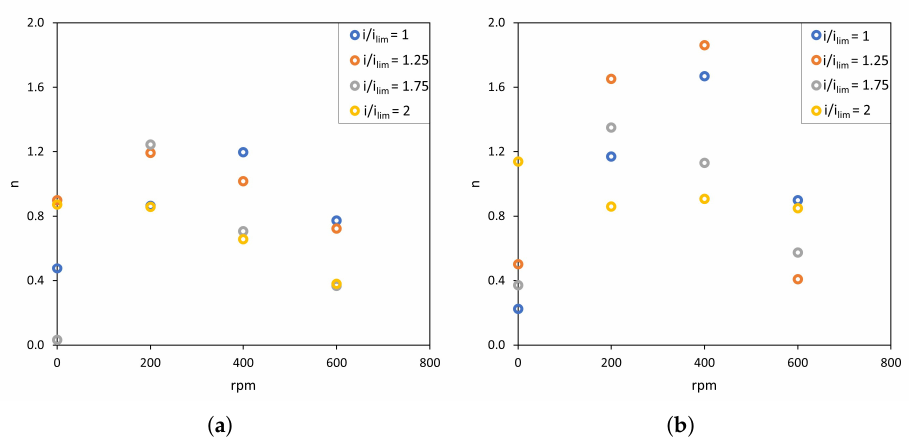
Figure 9. Evolution of the n value at various stirring rates. ( a ) AMV-N, ( b ) HC-A.